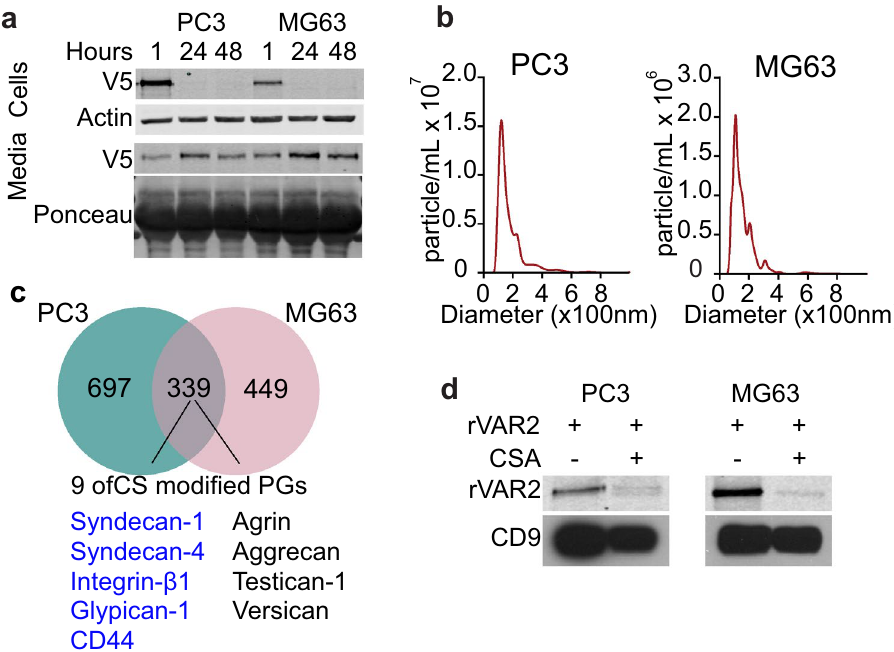
Figure 5. rVAR2 is released outside cells with exosomes. (a) PC3 and MG63 were treated with rVAR2, trypsinized lysated or media was collected at the indicated timepoints and blotted for the presence of rVAR2. Vinculin was used as loading control for cell samples and ponceau red stain was used as loading control for media samples. (b) Nanoparticle tracking analysis (NTA) of exosomes purified from the media of PC3 or MG63 cells. (c) Proteome of PC3 or MG63 exosomes as determined by mass spectrometry, common proteins present in exosomes from both cell lines are highlighted. CSPGs found in the exosomes of both cell lines are listed and known cell surface CSPGs are listed in blue. (d) Western blot of exosomes from PC3 or MG63 cells 48 h after rVAR2 treatment. 20 billion particles were used for loading and CD9 was used to determine the presence of